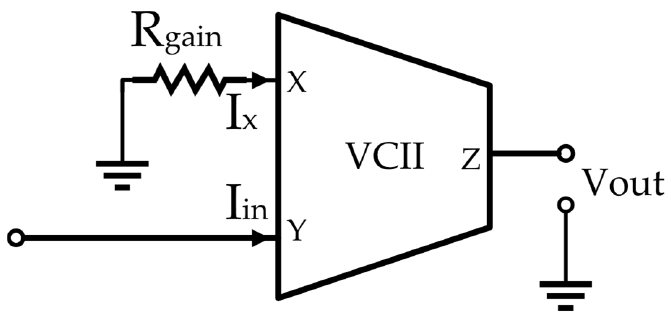
Figure 8. VCII as a transimpedance amplifier [11–13].